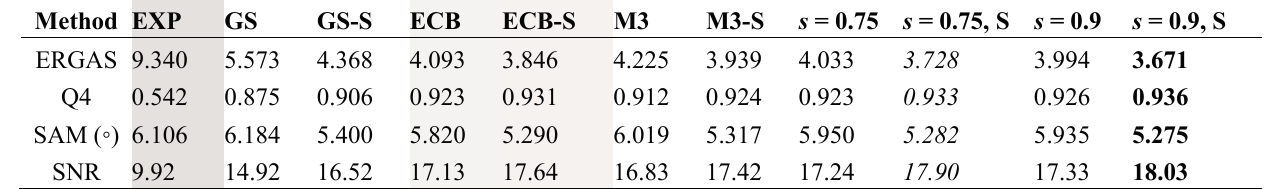
Table 6. Quantitative comparison of the fusion results to check the synthesis property of the Wald’s protocol for the WorldView-2 group 1 dataset at the reduced scale, i.e ., at 2.0 m. The font face indicators are identical to those in Table 2.